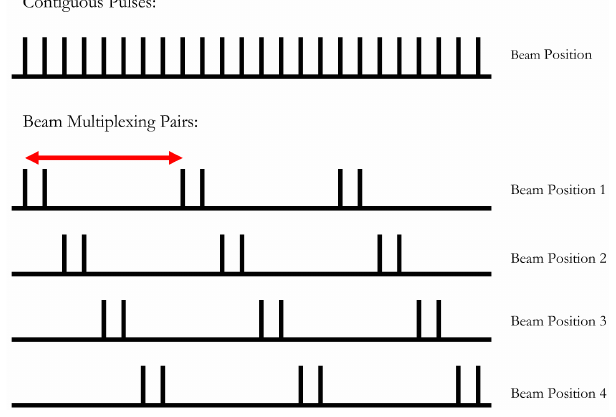
Figure 4. Illustration of contiguous and beam multiplexing pairs (Curtis, 2009).